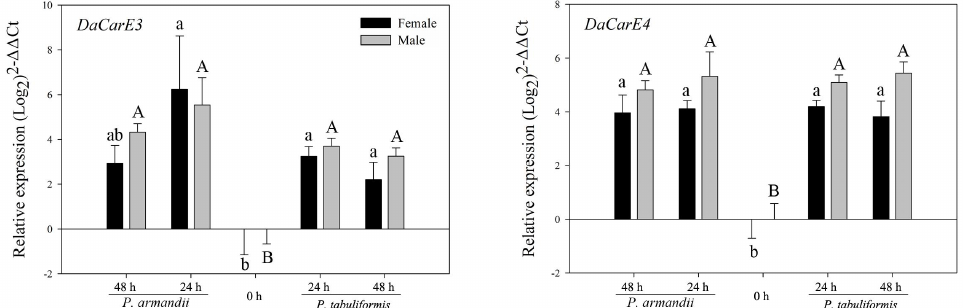
Figure 4. Realtime qPCR analysis of the relative expression of two CarE genes (mean ± SE) in D. armandi after being fed on two different diets for 24 and 48 h. Values > 1 on the logarithmic y-axis indicate upregulation. Gene expression was normalized with respect to the geometrical mean of β -actin and CYP4G55. The different letters indicate statistically significant differences in gene expression among different times for the same diet, compared using Tukey’s HSD ( p < 0.05). The 2 − ∆∆ Ct and SE values were log 2 transformed for